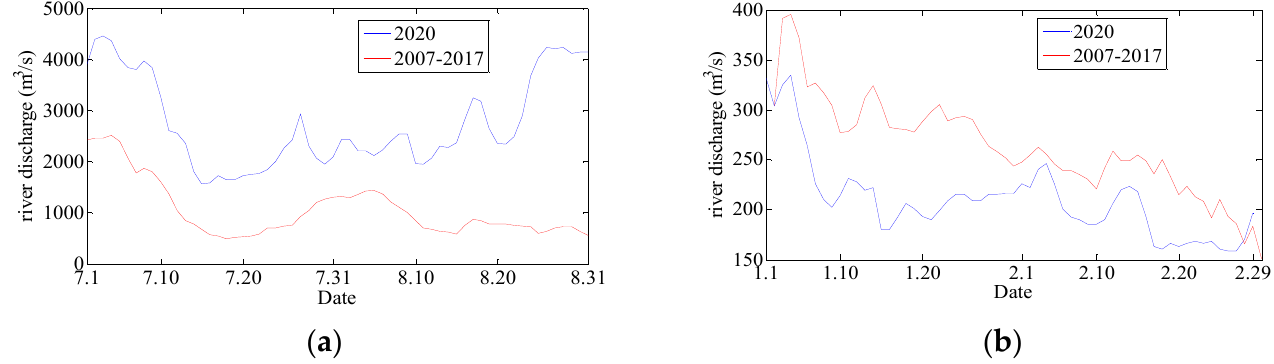
Figure 3. River discharge statistics in the wet season ( a ) and the dry season ( b ) in 2020 and 2007–2017 (wet season: 1 July–31 August; dry season: 1 January–28 February; data link: